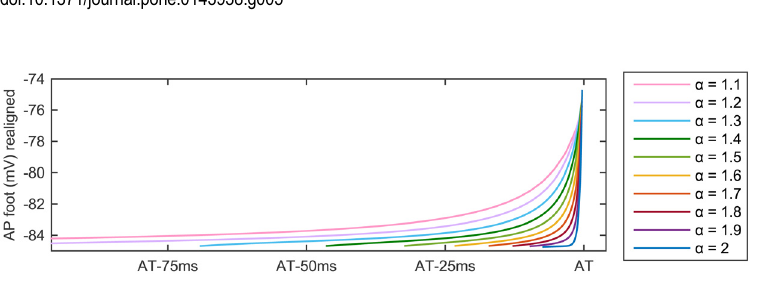
Fig 6. AP foot of the solution profile obtained at the node P 2 for ten different values of α 2 (1, 2]. To aid the visualisation of the differences produced by varying the fractional order, we align the AP foot of the ten solution profiles considered so that the activation time (AT) of the node P 2 coincides for all values of α .